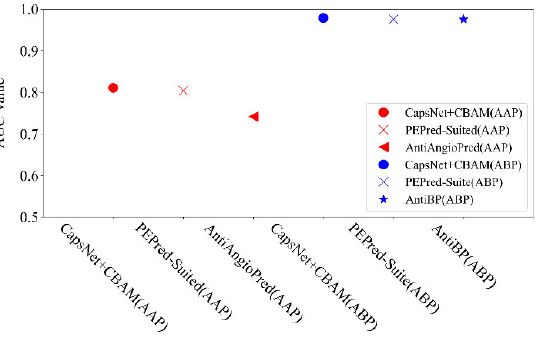
Figure 6. Comparison of AUC indicators by different methods on AAP and ABP datasets.